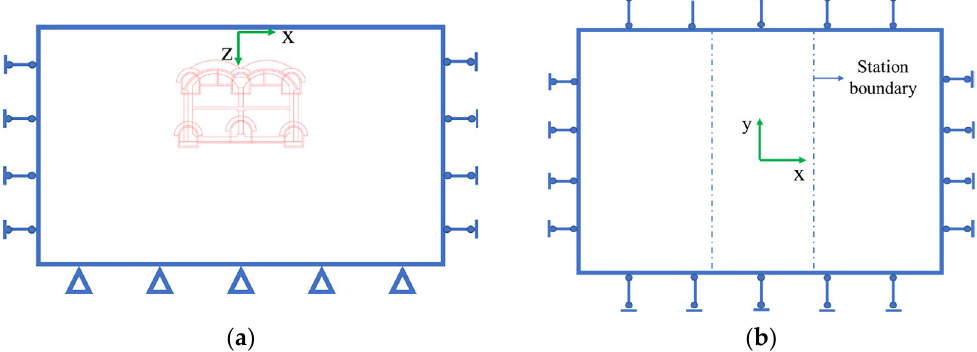
Figure 6. Schematic of the model boundary: ( a ) Front and ( b ) vertical views.